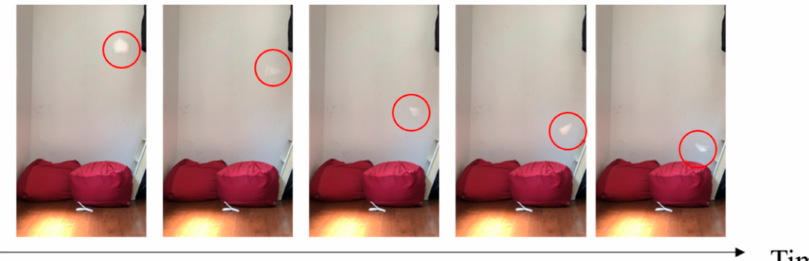
Figure 1. Model of wing fruit.